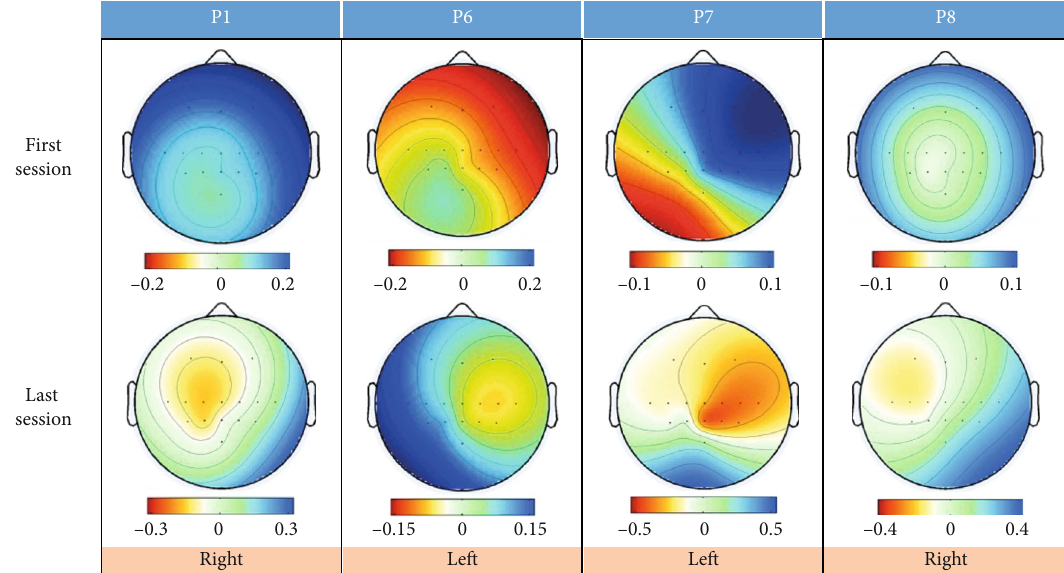
Figure 5: Topographic maps from four participants illustrating the fi rst and last spatial patterns extracted by the CSP